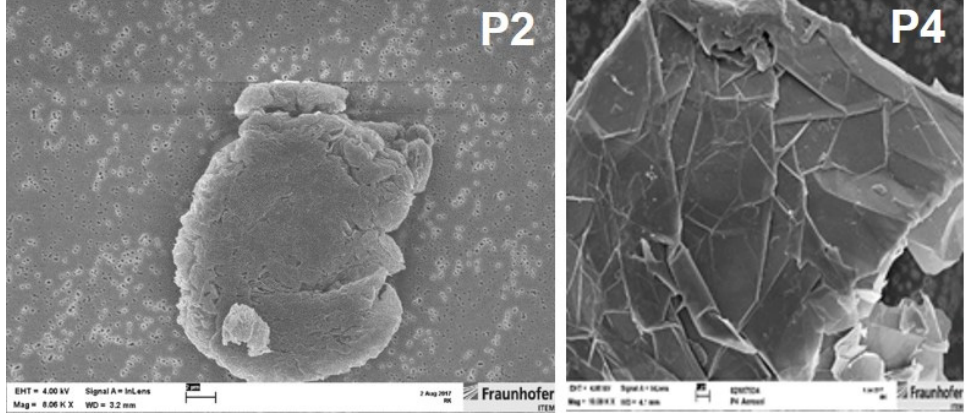
Figure 2. SEM photographs of aerosolized GRNP samples, i.e., P2 (left picture; SLG sample; magnification: 8000×) showing high and P4 (right picture; GNP sample; magnification: approx. 10,000×) showing low toxic potential in the in vitro screening with primary rat alveolar macrophages.